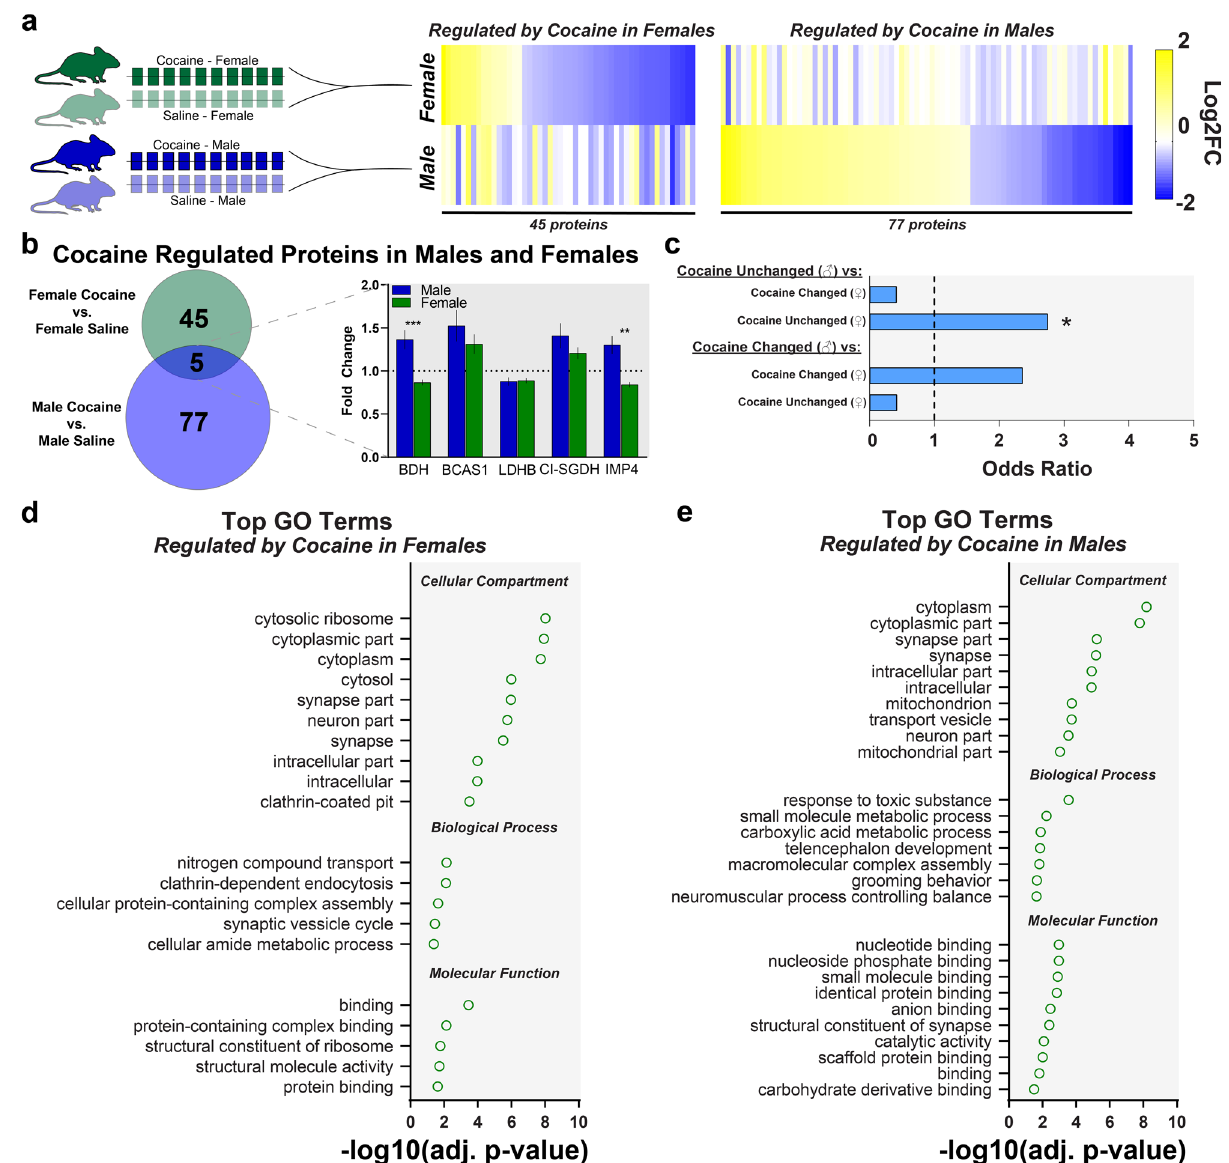
Fig. 4 Cocaine-regulated proteins are largely nonoverlapping in the accumbens of male and female mice. a Heat map denoting the proteomic dysregulation induced by cocaine. Each line is the differentially expressed proteins in the cocaine group in each sex compared to their respective saline controls. (Left) proteins signi fi cantly regulated by cocaine in females are on the top line. The bottom line is the same proteins in males (regardless of whether they were signi fi cantly different). (Right) the bottom line are the proteins signi fi cantly regulated by cocaine in males and the top line are those same proteins in females. b Of 122 total proteins regulated by cocaine self-administration in either males or females, only 5 were regulated in both sexes. (Inset) bar graph showing fold change in protein expression versus saline in each sex. Of the fi ve proteins regulated in both sexes, only three of those were going in the same direction. c Fisher ’ s exact test of odds ratio for protein list overlap of cocaine-regulated proteome in males and females. Odds ratio analysis shows that proteins regulated by cocaine in males are largely nonoverlapping with proteins regulated by cocaine in females. In order to conduct gene ontology (GO) analysis protein names had to be converted to associated gene names. These conversions are available in Supplementary Data 1. Top GO terms in proteins regulated by cocaine in d female and e male mice. Bar graphs reported as mean ± SEM. * p < 0.05, ** p < 0.01, *** p <